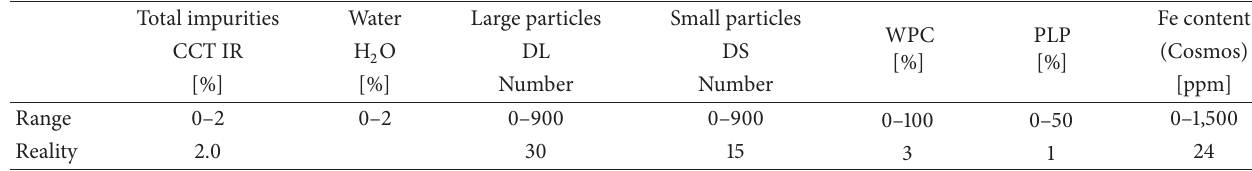
Table 6: The measurement results for sample C.